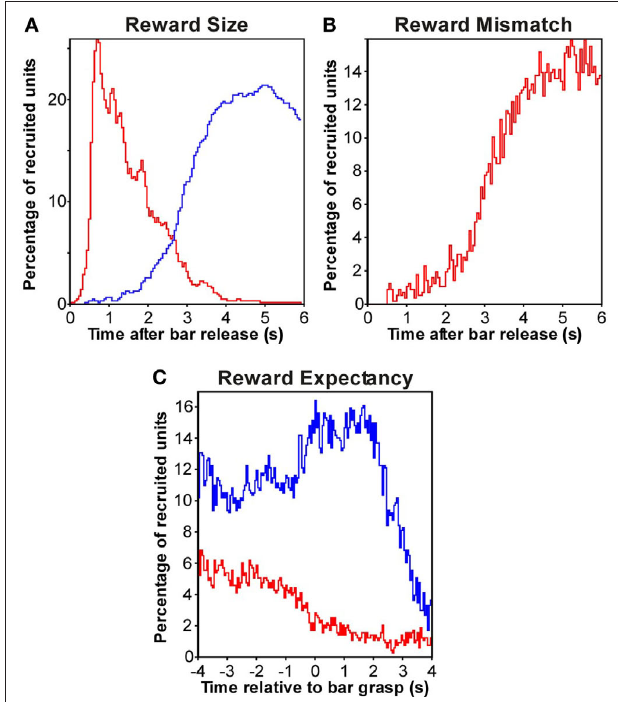
Figure 4 | Population responses in auditory cortex related to reward feedback. (A) Reward-size coding: Recruitment of the percentage of multiunits in each time bin in which the firing was significantly stronger (red) for at least one of the following three comparisons: (1) large and small reward trials (2) large and no-reward trials (3) small and no-reward trials. The blue curve shows the recruitment of multiunits whose firing was significantly stronger for reversed comparisons. See also Figure 5 . (B) Reward mismatch coding: recruitment of the percentage of multiunits whose firing increased (red) with the size of the reward mismatch. For each time bin, the percentage of multiunits is shown whose firing was significantly stronger for at least one of the following three comparisons: (1) trials with large and small reward mismatch; (2) trials with large and no reward mismatch; (3) trials with small and no reward mismatch. Note that this curve closely matches the blue curve in (A) . See also Figure 7 . (C) Reward expectancy: recruitment of the percentage of multiunits whose firing was significantly stronger (red) or weaker (blue) when trials with large reward expectancy were compared to trials with small expectancy. Note the increasing separation of the two curves after bar